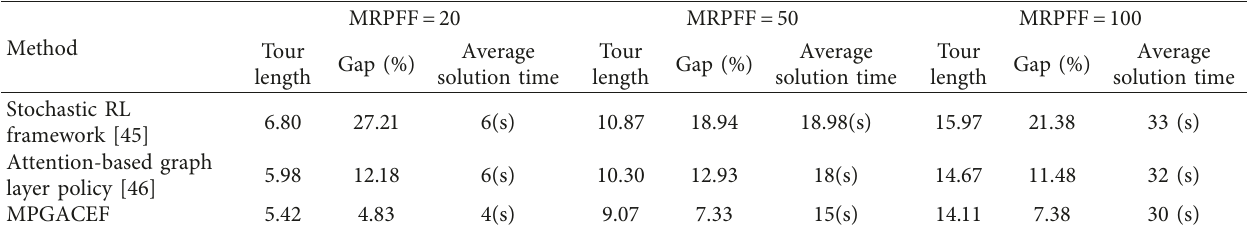
Table 2: The average tour length, gap percentage, and average solution time of MRPFF.